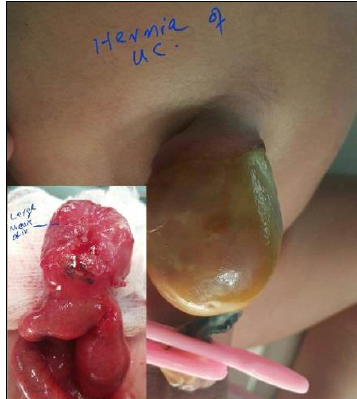
Figure 1: Small hernia of umbilical cord. Inset shows Meckel’s diverticulum as a content of HUC. [Courtesy of